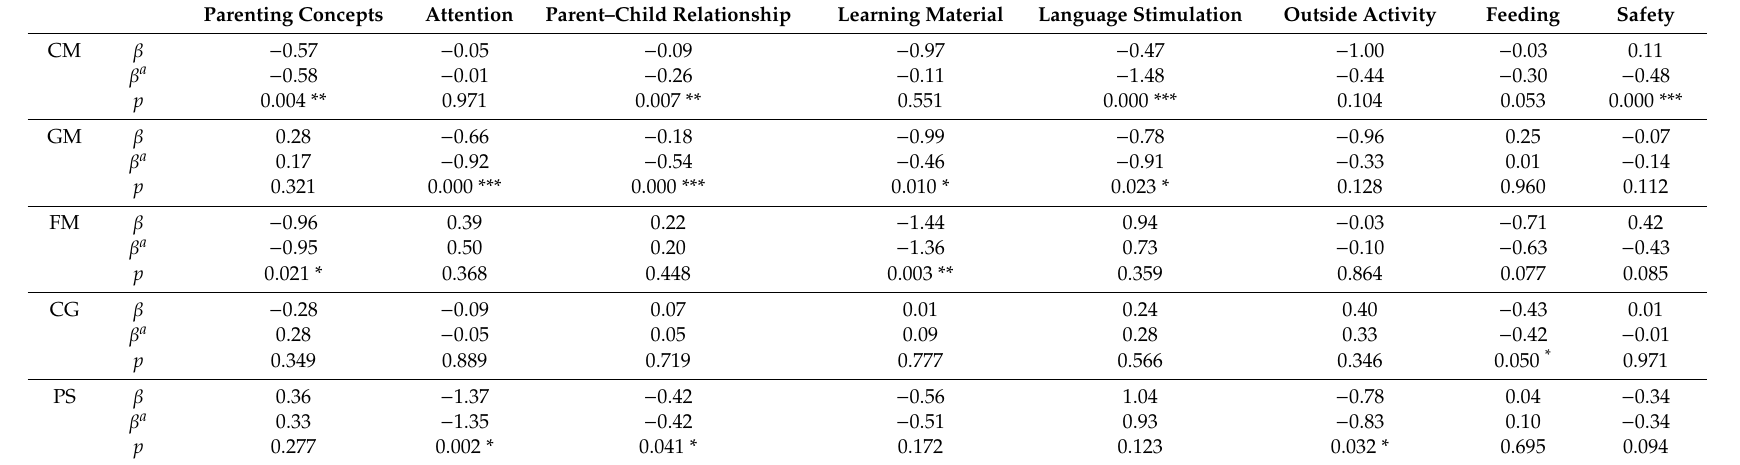
Table 2. E ff ects of parenting quality on children’s development